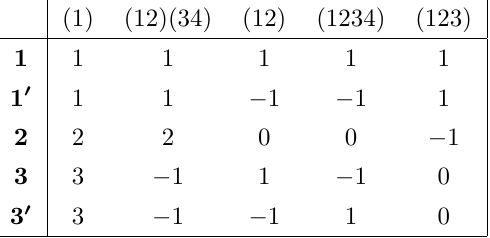
Table 1 . The character table of S 4